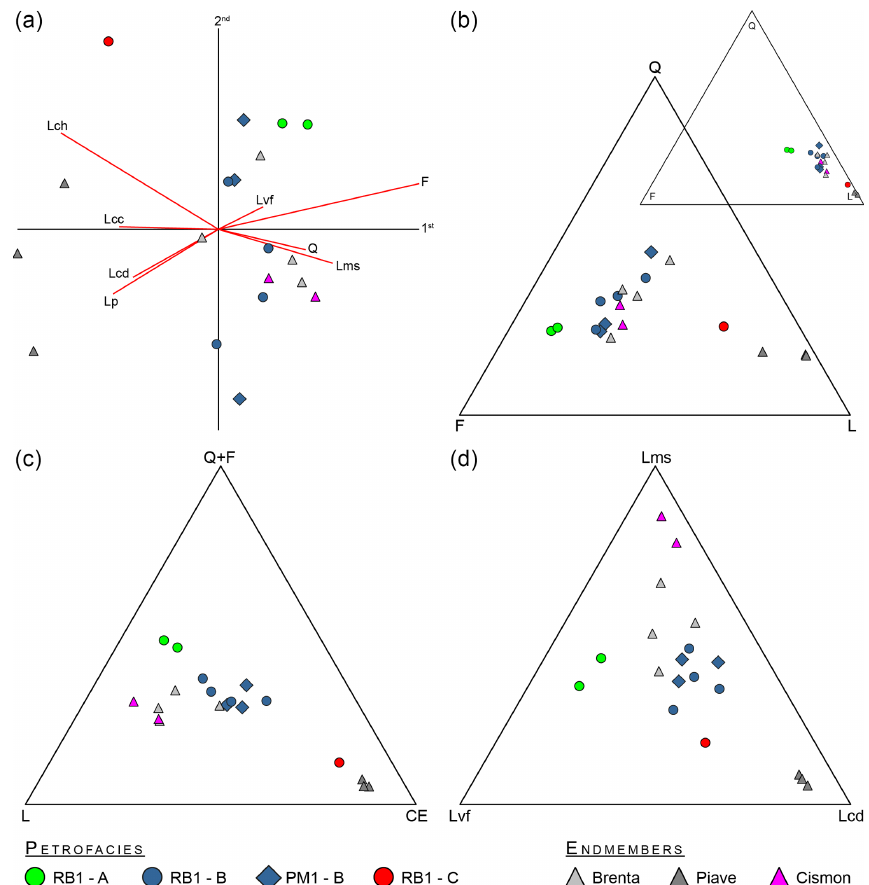
Figure 7. (a) Compositional biplot of the principal components. (b) The original (small) and centred (large) QFL diagrams. (c) The Q + F, L (non-carbonate lithic) and CE (carbonate lithic and cherts), and (d) Lms, Lvf and Lcd ternary diagrams showing the results of the sand petrography analyses performed on the RB1 and PM1 cores. Endmembers following Garzanti et al. (2006) and Monegato et al. (2010). See Table 2 for component